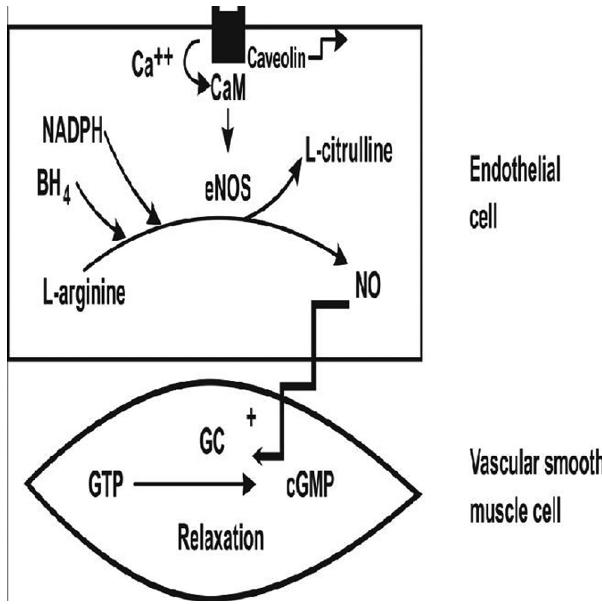
Figure 1 - Production of NO by endothelial cells. Modified from Davignon J, Ganz P. Role of endothelial dysfunction in atherosclerosis. Circulation . 2004;109 (suppl III): III27- III32. BH 4 =